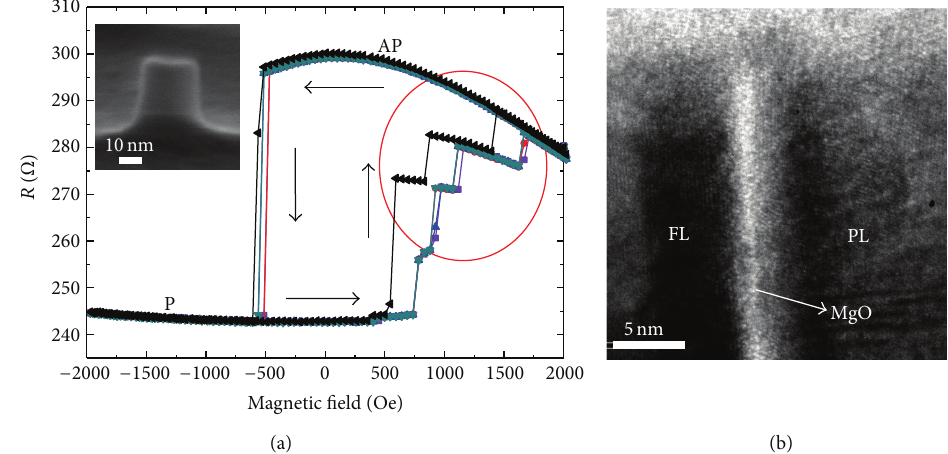
Figure 1: Multidomain properties of fabricated STT-MRAM cell. (a) MR characteristics of the pMTJ measured in air with perpendicular magnetic fields swept between − 2000 and 2000 Oe, at a sample bias voltage of 50 mV. AP-to-P reversal in spin arrangement of two ferromagnetic layers is shown at the point of − 580 Oe; P-to-AP reversal is shown ranging from 500 to 1700 Oe. (Inset) SEM image of individual pMTJ nanopillar with 30-nm junction. (b) High resolution transmission electron microscopy (HR-TEM) image of the pMTJ after ion milling. Brightness difference of sidewall of pinned and free layer (PL and FL) shows formation of multidomain ferromagnetic layers and damage from fabrication process, lithography, and ion milling.